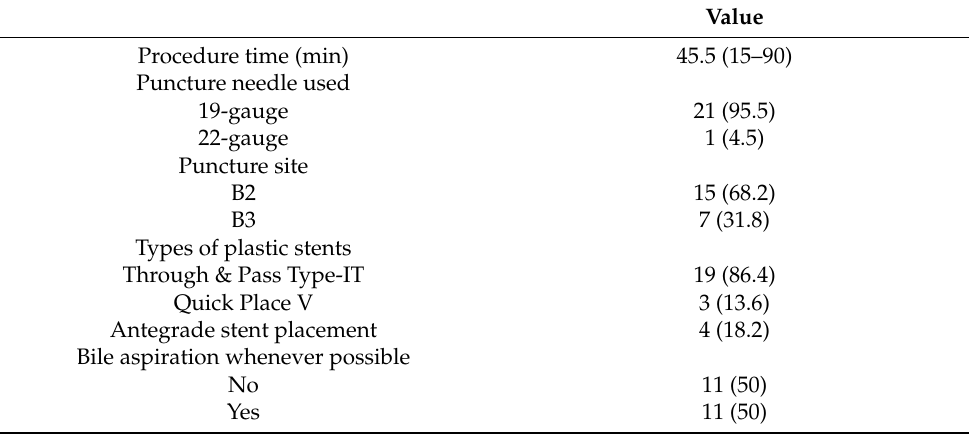
Table 2. Procedure outcomes.